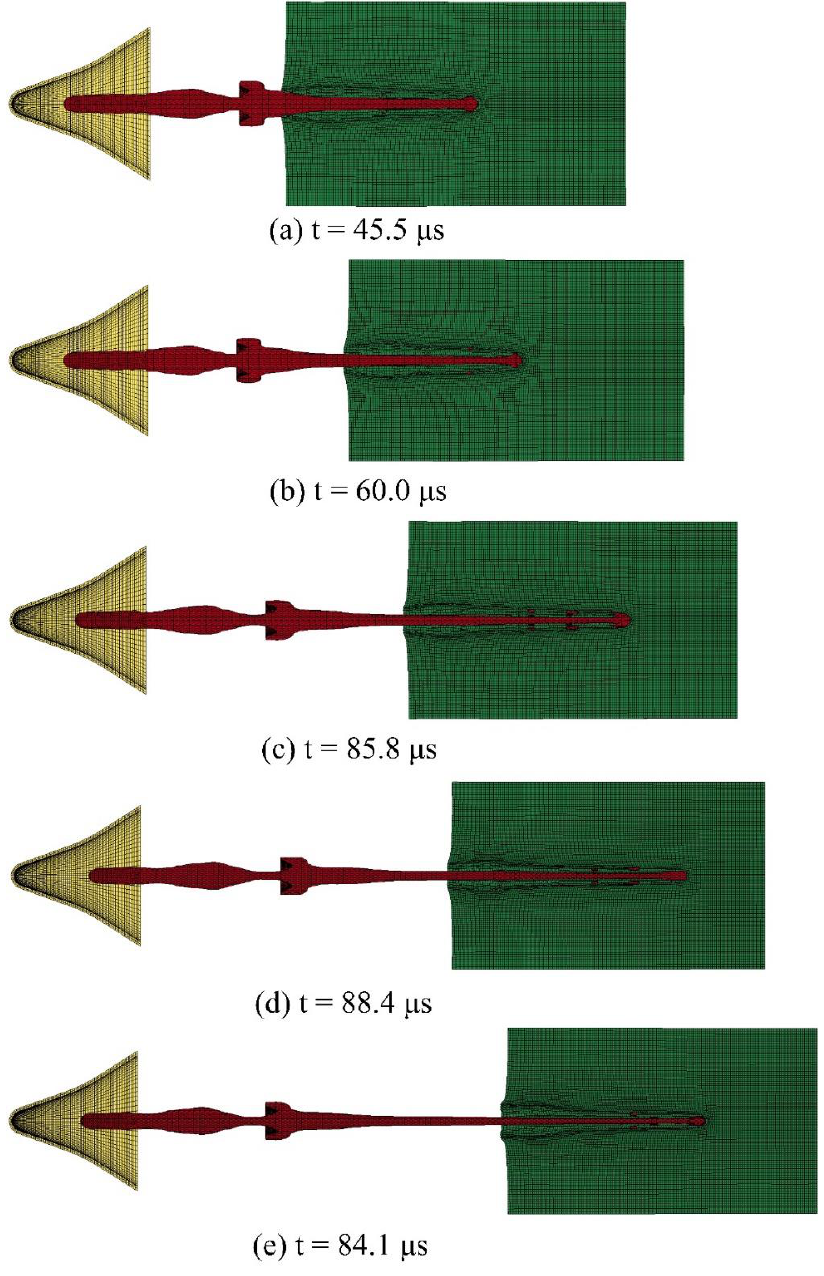
Figure 6. Penetration result of the standoff is 1 – 3 LD.